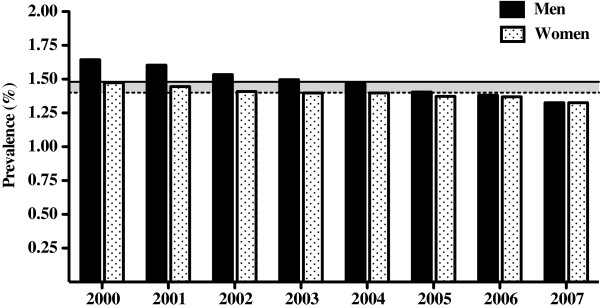
Bars represent the annual prevalence of claims-based recurrent low back pain in the Canadian province of Quebec for men (black bars) and women (shaded bars). The 8-year mean prevalence for men (solid line) and women (dotted line) shows the difference between the sexes (shaded area). Both distributions display a progressive and significant decrease from 2000 to 2007.